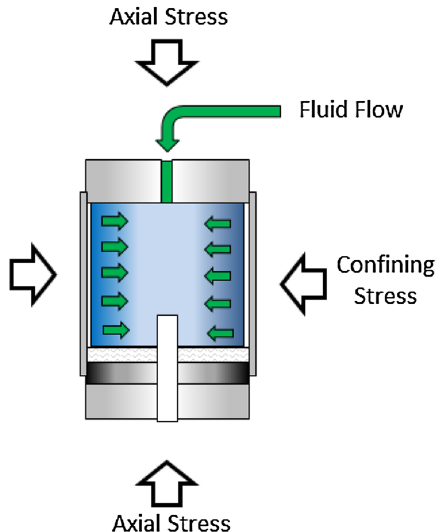
Fig. 10 Sand production testing